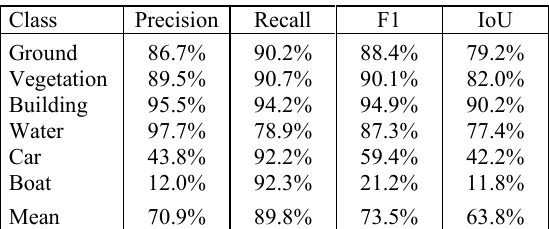
Table 5 . SUM benchmark dataset. Per - class results of image segmentation after texturing and voting.